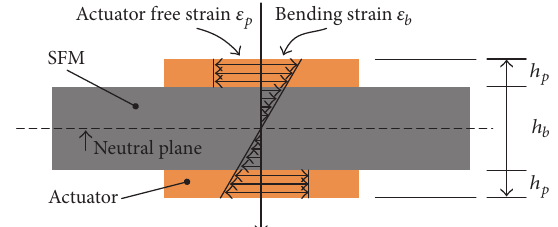
Figure 2: Model of the SFM with surface bonded